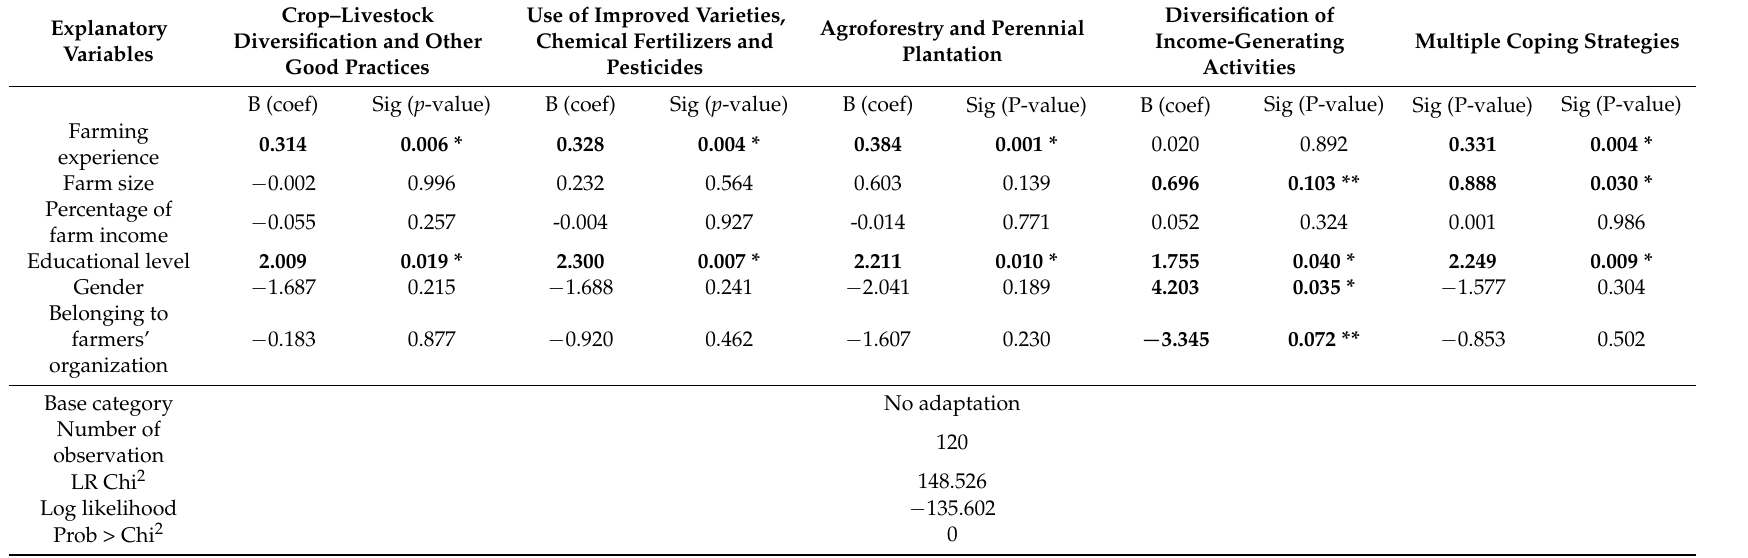
Table 5. Determinants of a farmer’s choice to use a specific climate change adaptation